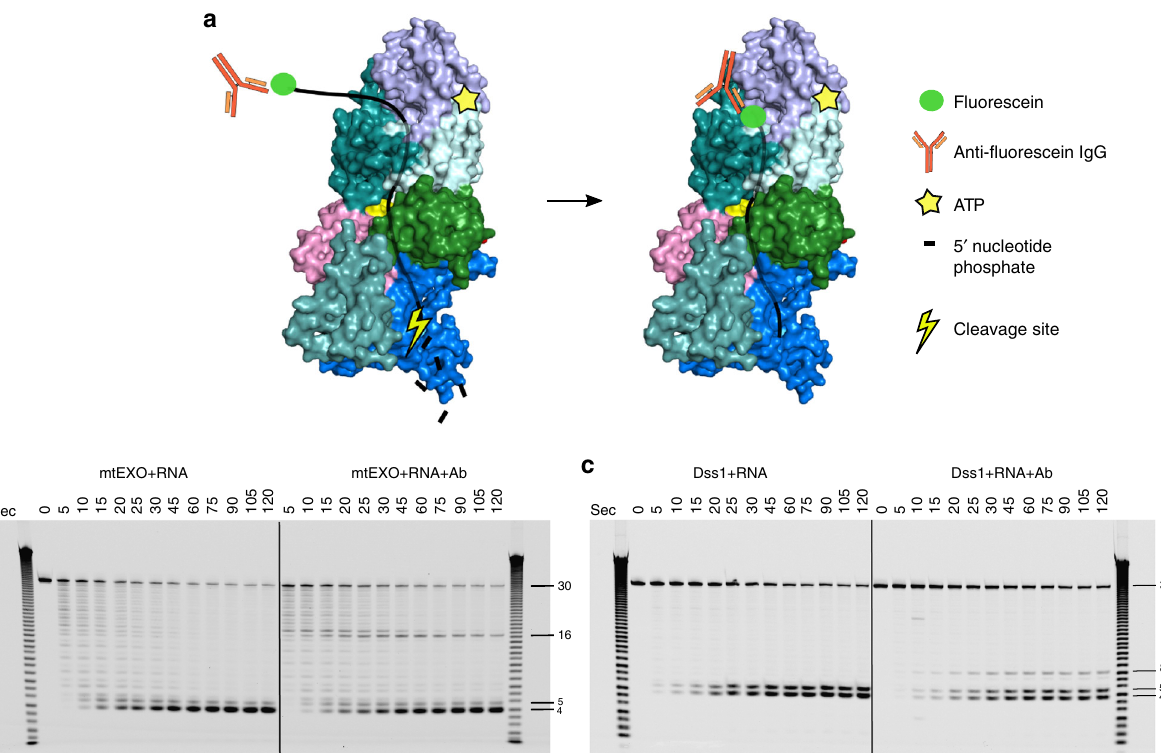
Fig. 4 Biochemical validation of the length of RNA-binding channel within the Cg- mtEXO complex and Cg- Dss1 alone. a Schematic of the experiment with fl uorescein-labeled RNA degradation by mtEXO in the presence of anti- fl uorescein antibody that blocks RNA translocation. b , c Exoribonuclease activity assay of full-length Cg -mtEXO and Cg- Dss1, respectively, on the fl uorescein-labeled substrate W30-F (see Supplementary Table 2 for sequence) in the presence and absence of the anti- fl uorescein antibody. The reaction products at the time-points indicated on top of the gel were analyzed by 20% TBE- urea PAGE and scanned for fl uorescent signal of the